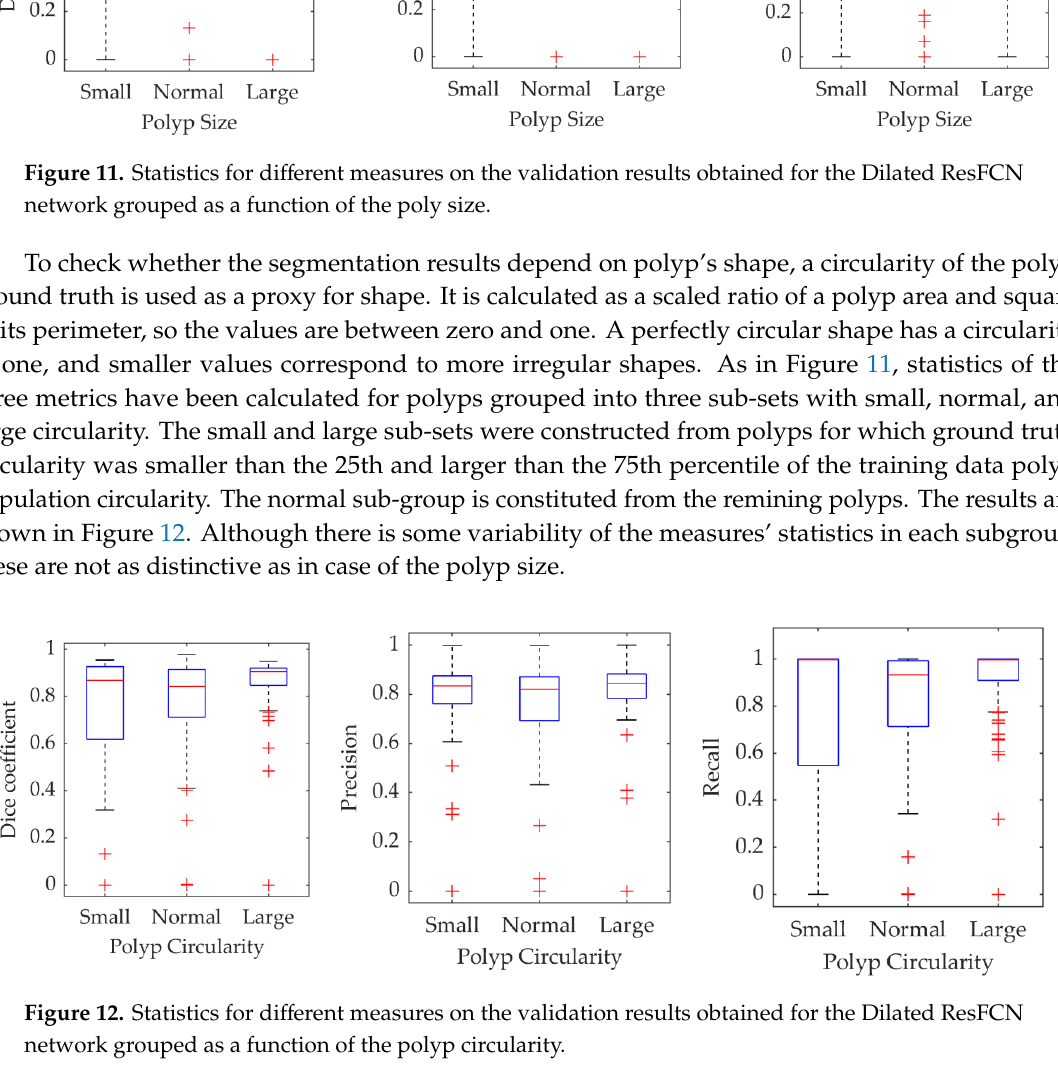
Table 2. Median and mean values recorded for different measures and segmentation methods.